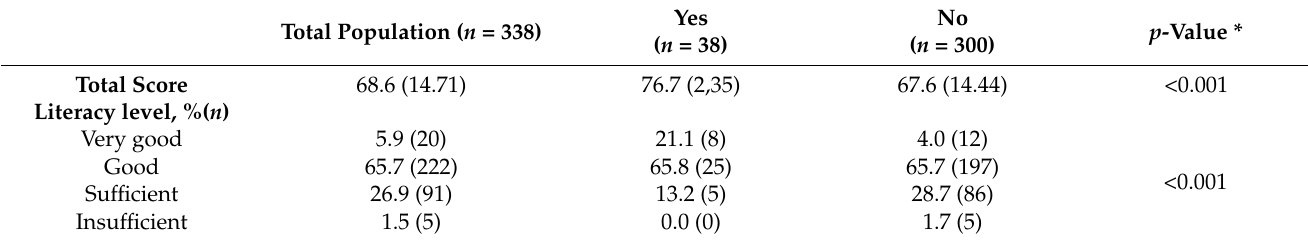
Table 4. The literacy level of the population studied according to whether they have family members in the nutrition area.